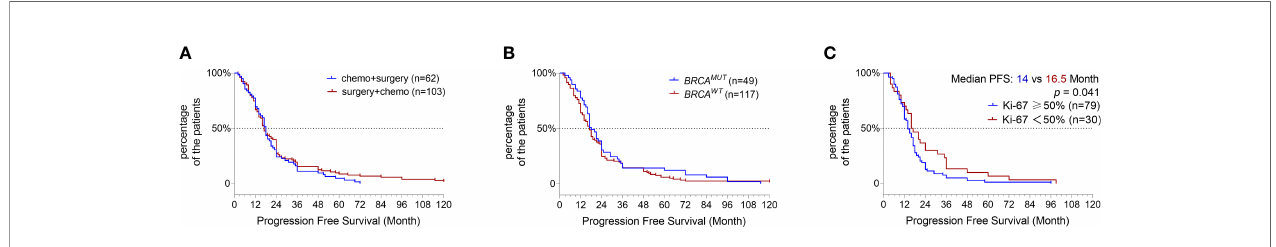
FIGURE 3 | Progression-free survival (PFS) analysis. Kaplan – Meier plot shows the comparison of PFS in serous OC patients primarily treated by surgery versus adjuvant chemotherapy (A) , BRCA MUT carriers versus BRCA WT carriers (B) , and the patients with high ki-67 expression of ≥ 50% versus < 50%